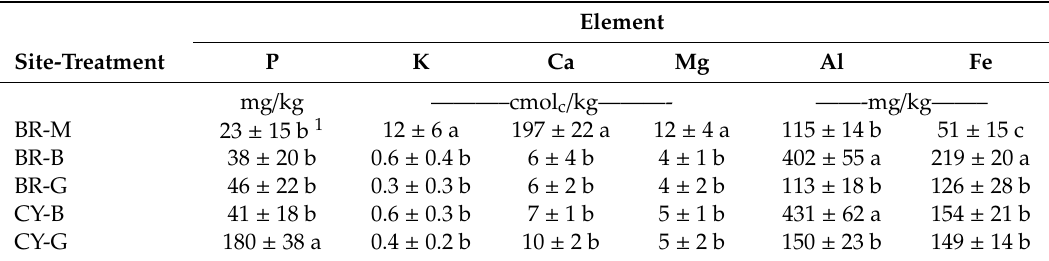
Table 4. Extractable nutrients (means ± one standard error). from mine soils at Birch River (BR) and Catenary